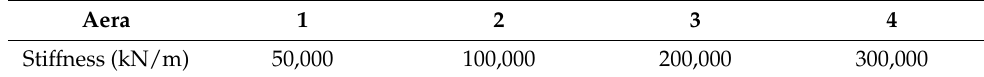
Table 4. The mixed stiffness of deformation adjustor.